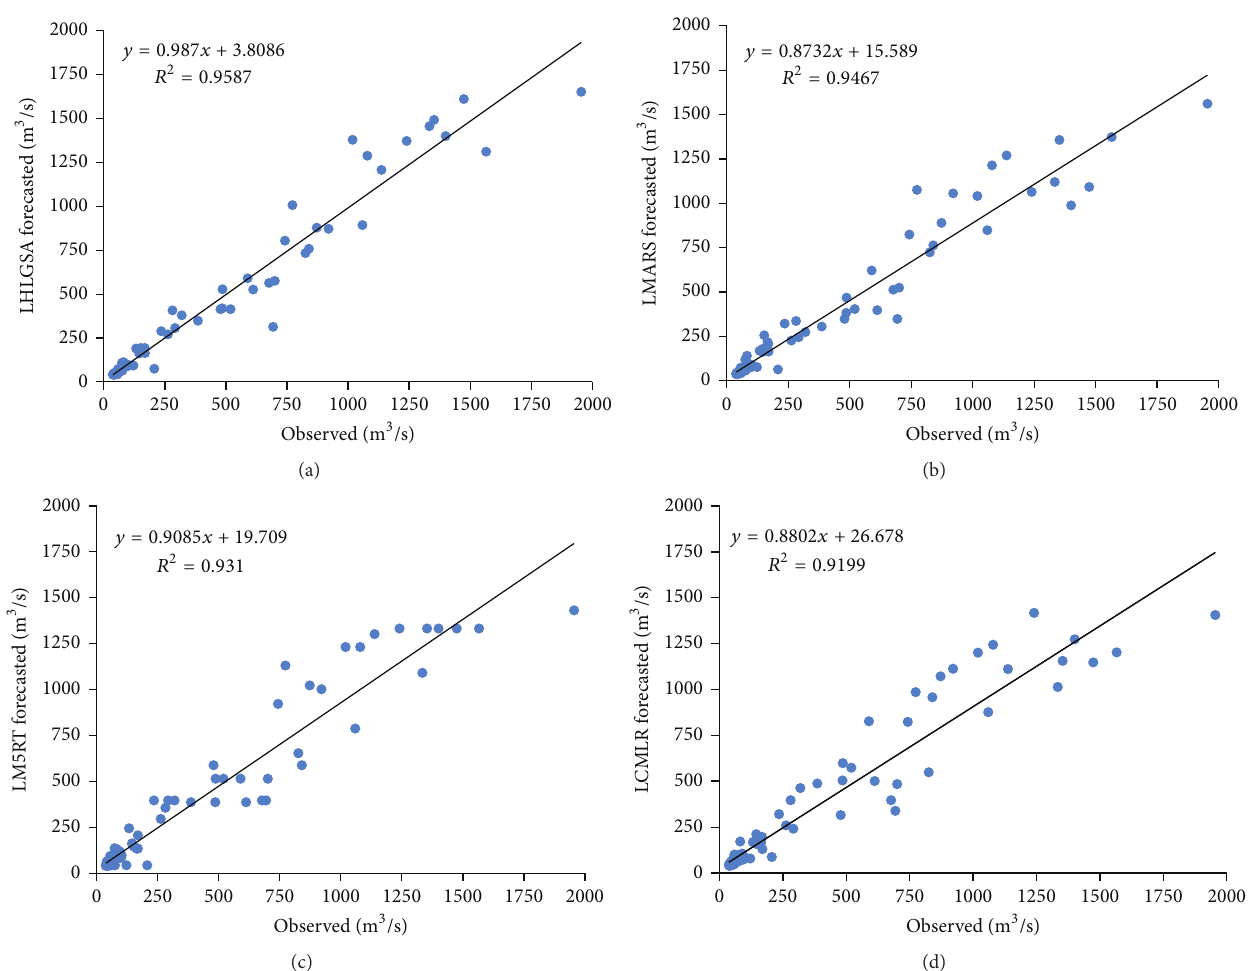
Figure 12: The observed and forecasted river flow by the LHLGSA, LMARS, LM5RT, and LCMLR models using DS3 data set: Shyok catchment.